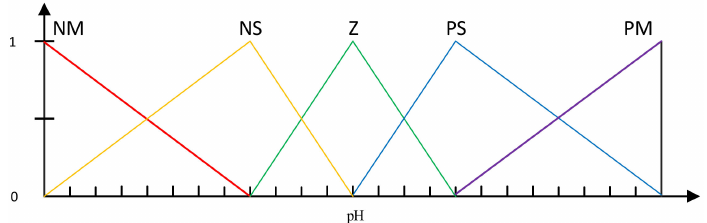
Figure 4. pH membership function.